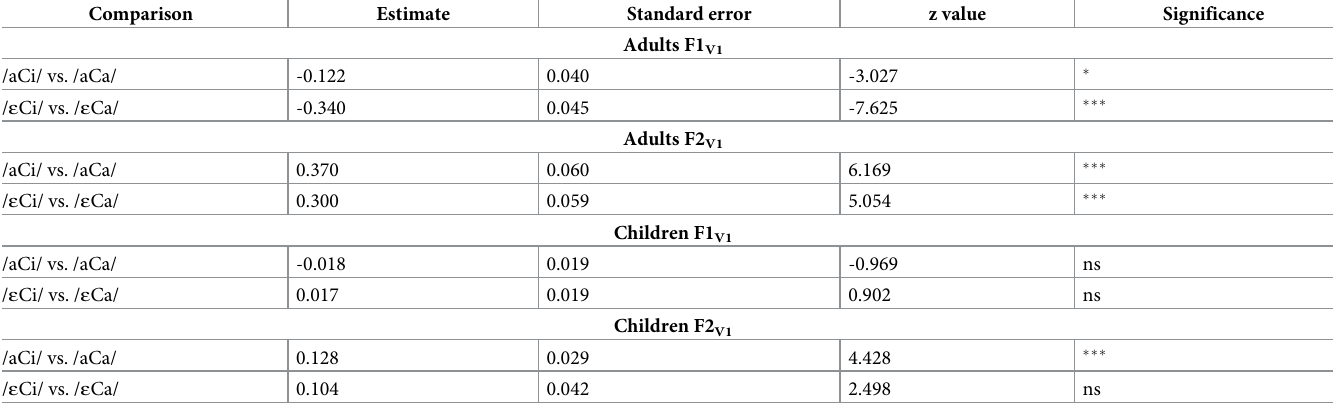
Table 1. Results of multiple comparisons of z-scored formant values performed on V 2 levels, within groups and V 1 .